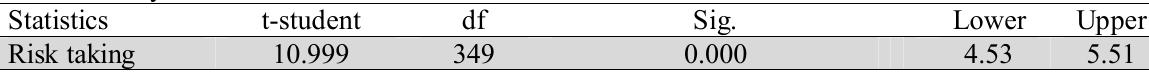
The summary of t-student test